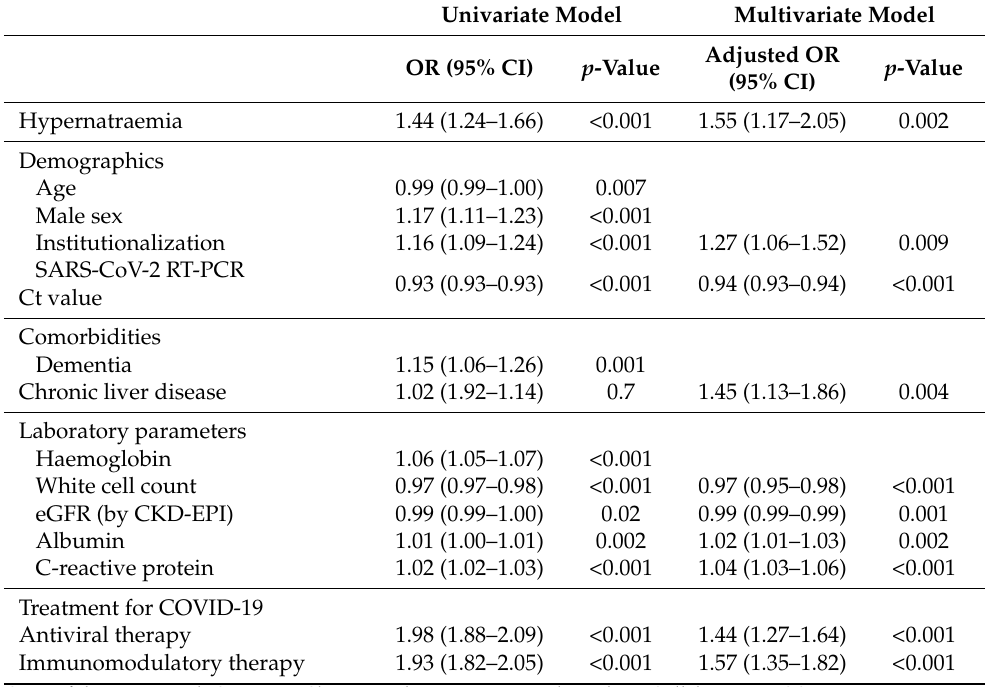
Table 10. Risk factors for prolonged hospitalization (i.e., >7 days) among surviving patients with COVID-19. Univariate Model Multivariate